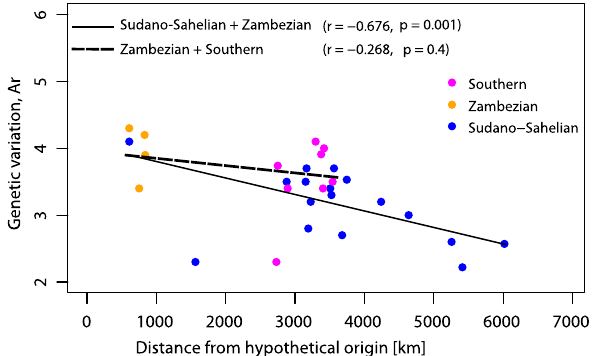
Figure 3. Genetic variation (rarified allelic richness, Ar) of populations of Senegalia senegal as a function of distance from assumed East African origin of the range expansion into the Sudano-Sahelian region and between Eastern and Southern ranges